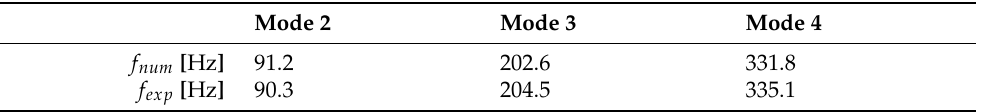
Table 2. Comparison between the natural frequencies of the considered modes (numerical and experimental).